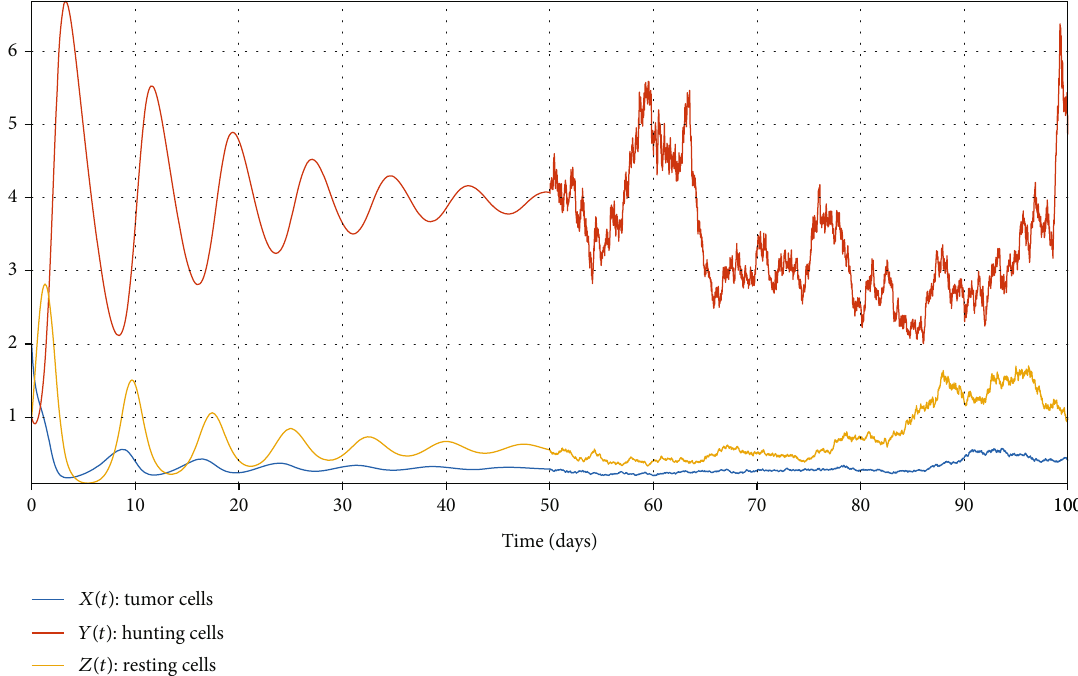
Figure 2: Time series trajectories of the piecewise systems (10) and (11) for c = 0 : 21 , c